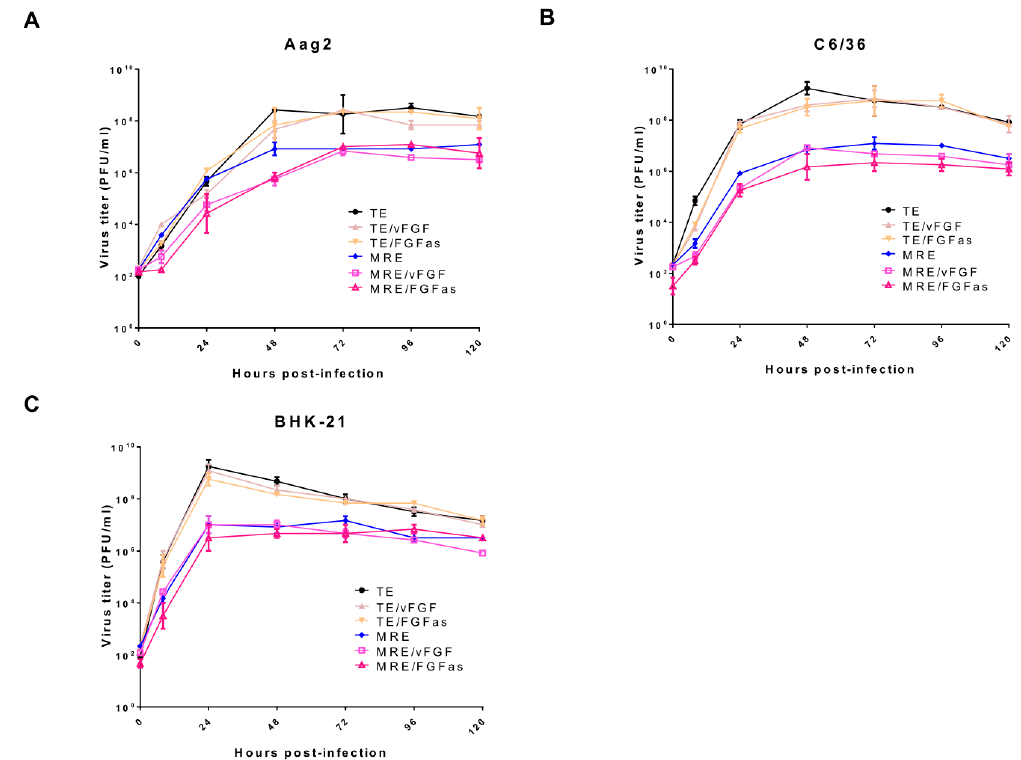
Figure 4. Effect of vFGF expression on SINV replication in cultured cells. Aag2 ( A ), C6/36 ( B ) and BHK-21 ( C ) cells were infected with the indicated viruses at an MOI of 0.001 PFU/cell. Supernatants from infected cells were collected at the times shown to determine virus production by TCID 50 assays. The bars indicate the means ± standard error of three independent experiments. Results were analyzed by two-way ANOVA for Aag2 (TE viruses, p = 0.73; MRE viruses, p = 0.037), C6/36 (TE viruses, p = 0.56; MRE viruses, p = 0.13), and BHK-21 (TE viruses, p = 0.84; MRE viruses, p = 0.54).